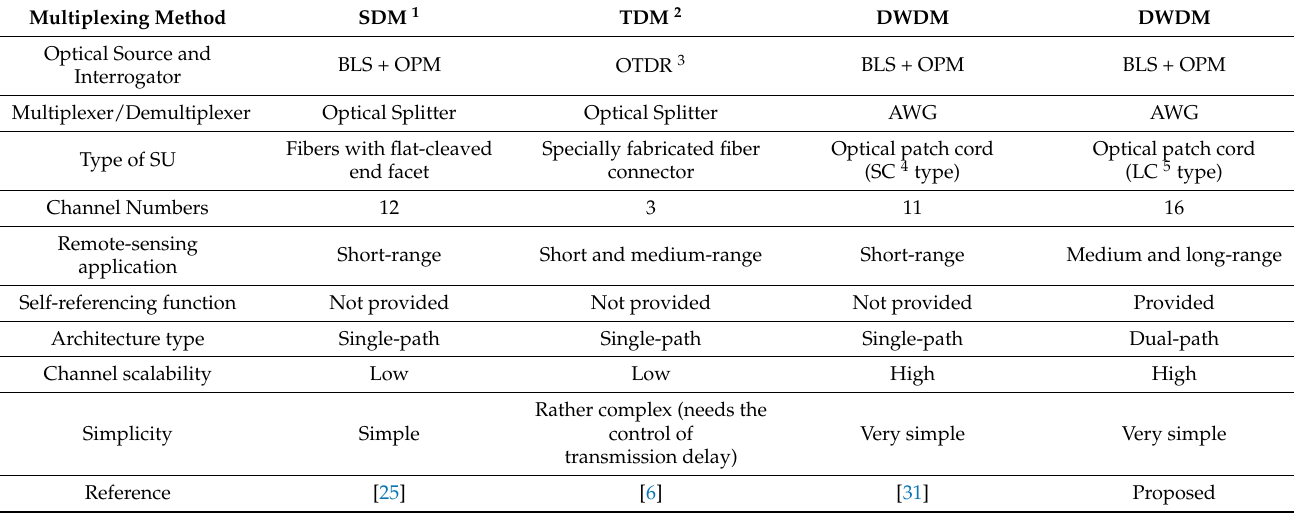
Table 1. Comparison of various multiplexed passive optical fiber sensor networks based on power measurement method for water-level